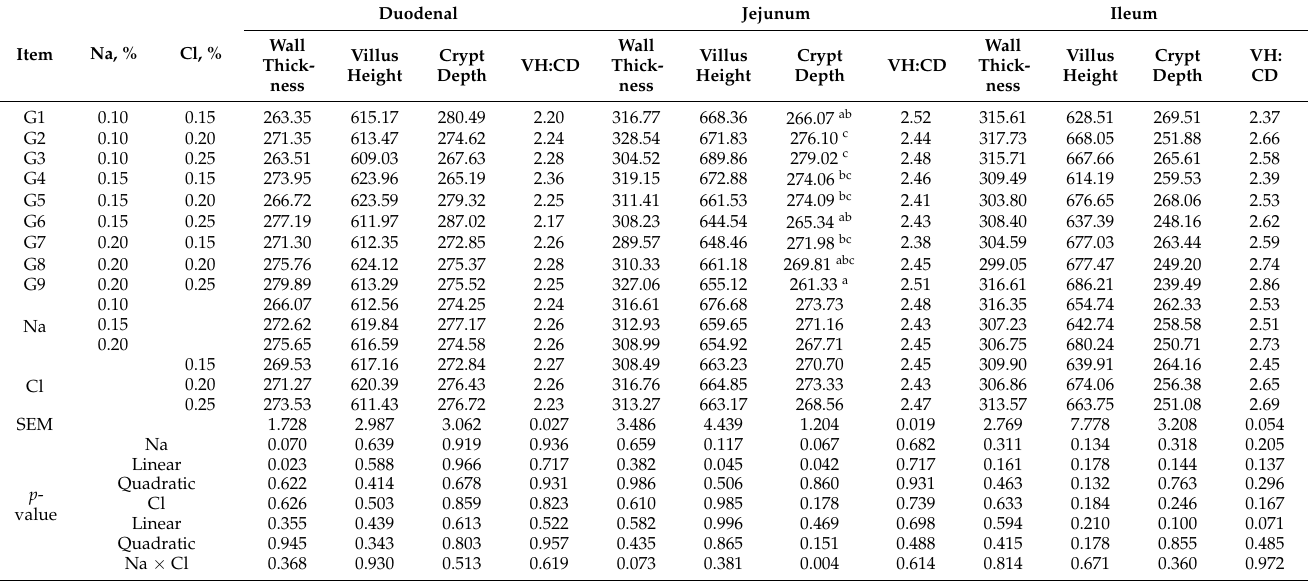
Table 4. Effects of dietary Na and Cl on the intestinal morphology of 70-day-old geese ( n =